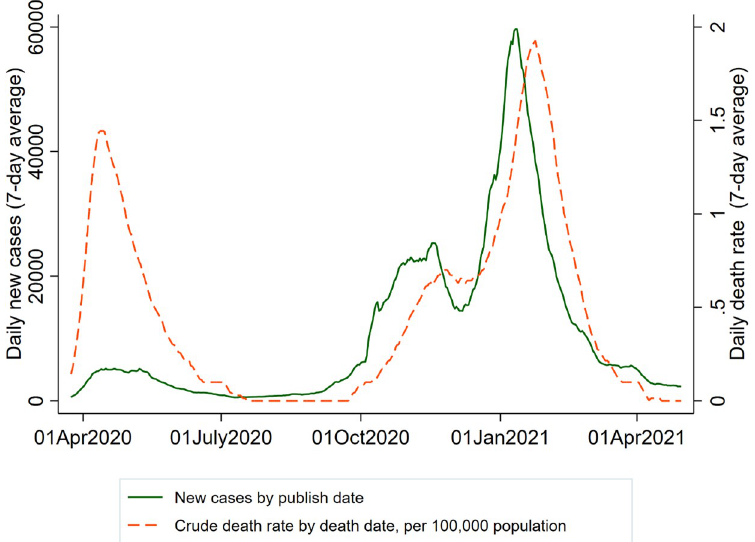
Fig 1. COVID-19 pandemic in the UK. Note: Data source: https://coronavirus.data.gov.uk/details. Crude death rate is new deaths within 28 days of a positive test per 100,000 population.